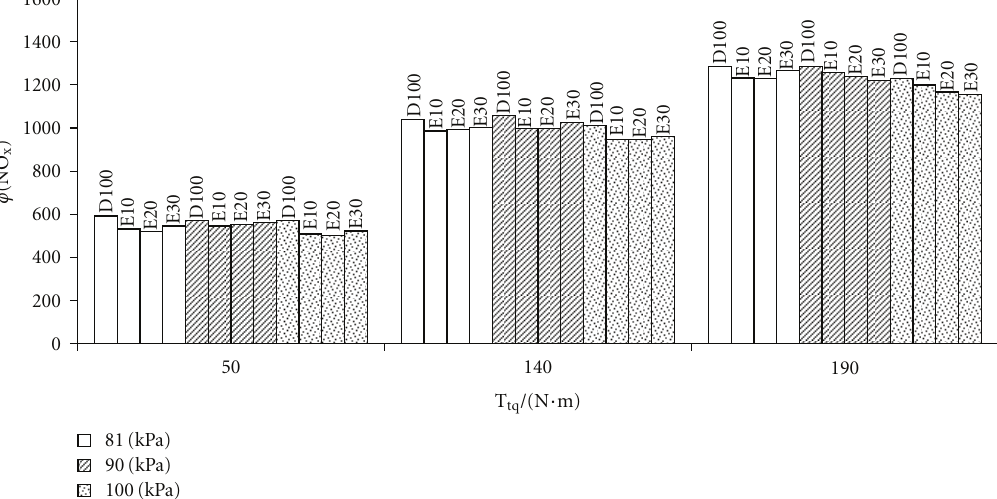
Figure 10: Comparison of NO x emission of di ff erent atmospheric pressure and mix proportion at speed 3200